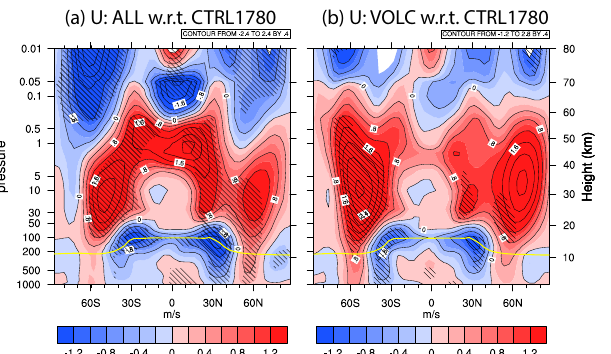
Fig. 9. Absolute JJA seasonal differences in temperature (left) and mean zonal wind (right) of the DM-EPP experiments with relation to the DM-CTRL1780 forcing run. Hatched areas are significantly different on a Student’s t test with α = 5%. The yellow line illus- trates the WMO tropopause height.